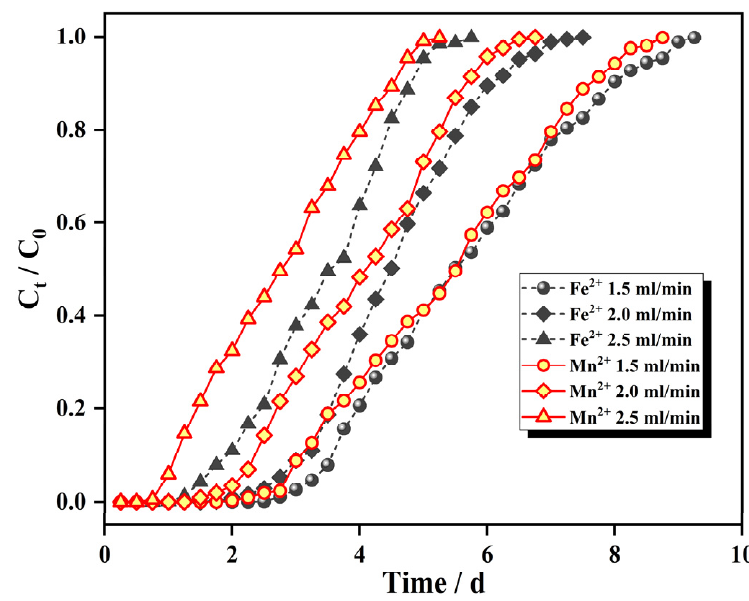
Figure 8. Breakthrough curves at different flow rates.